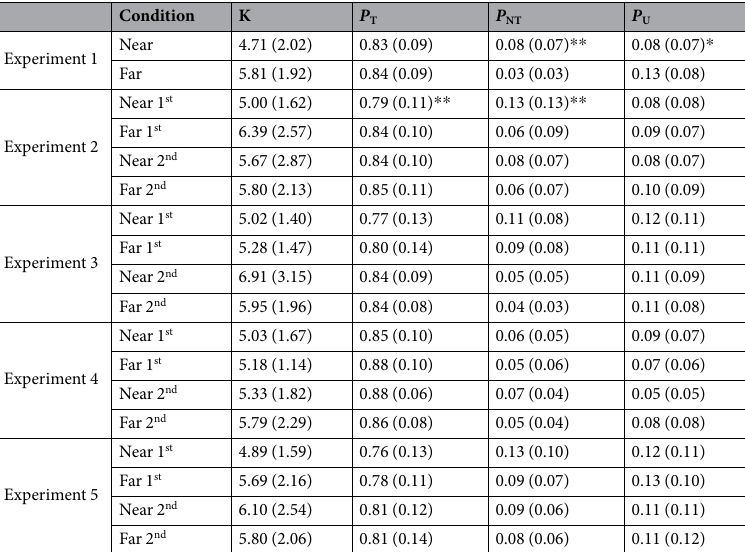
Condition K P T P NT